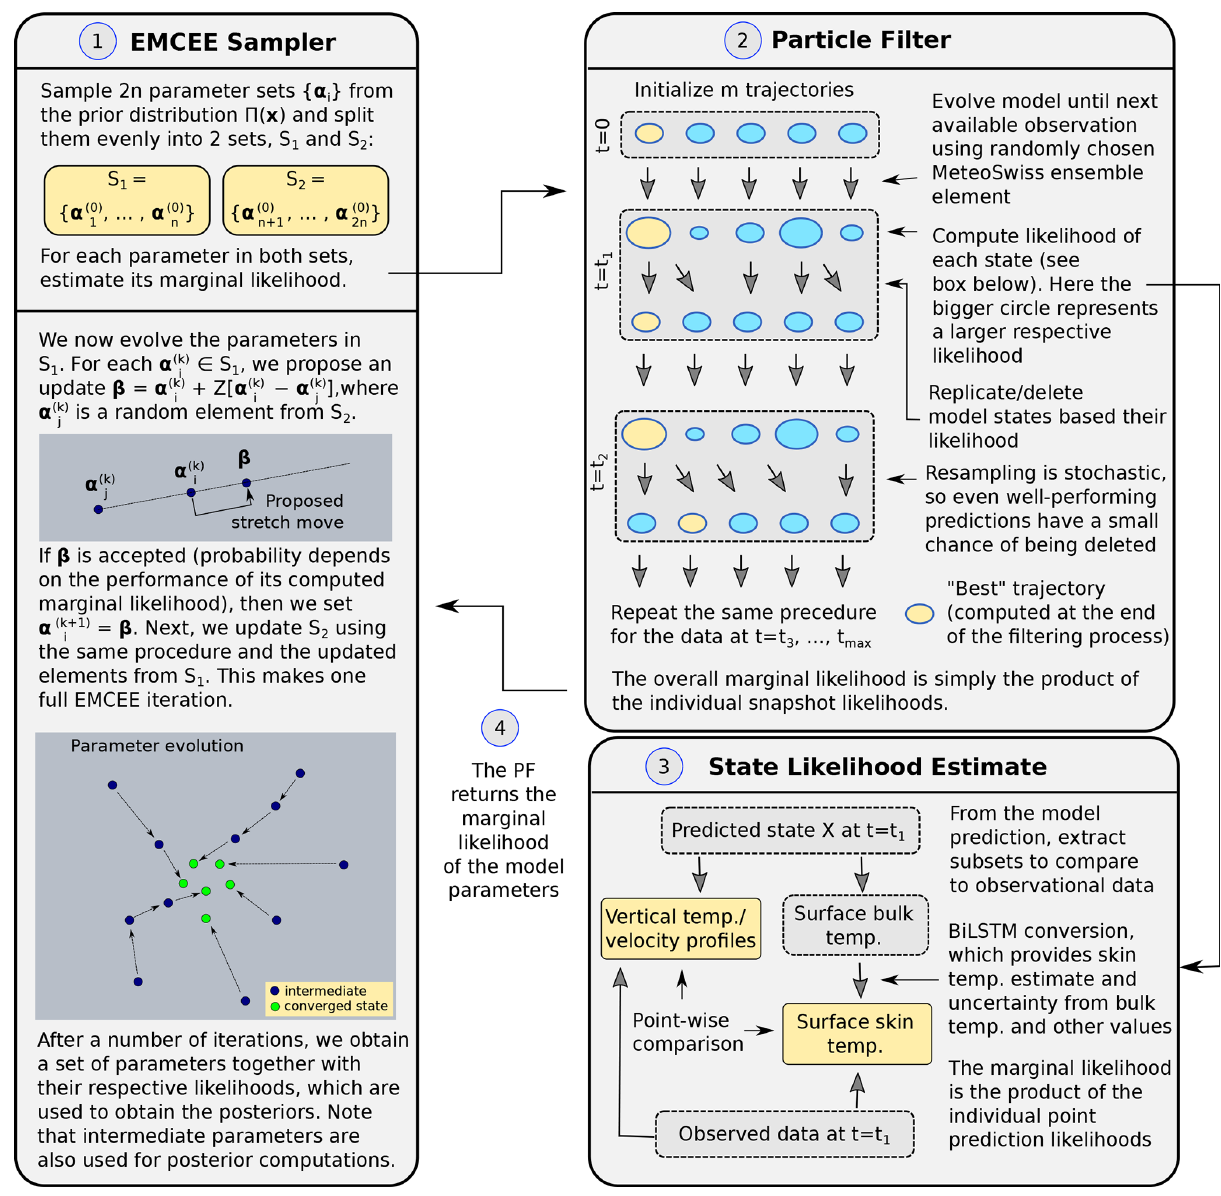
Figure 2. A simplified visualization of the data assimilation framework that we use in this paper. The EMCEE sampler proposes 2 n walkers (also called chains in SPUX ), whose marginal likelihood is then evaluated using the particle filter (PF). The PF resamples trajectories via deletion/replication with respect to their dataset and observational error